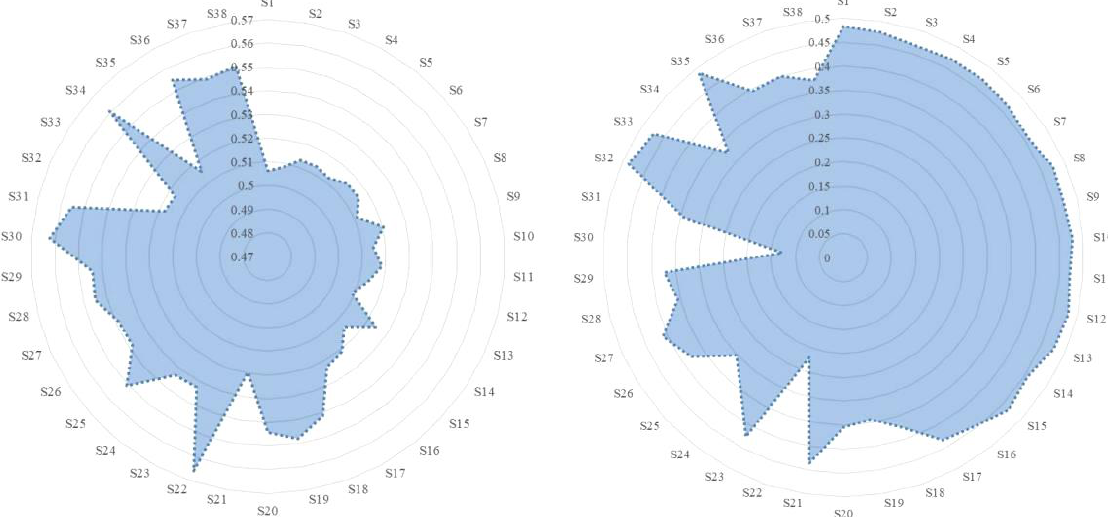
Figure 1. The weights A s1 ( left ) and A s2 ( right ). Table 5. HEP comparisons between Scenario 1, Scenario 2, and reference data.